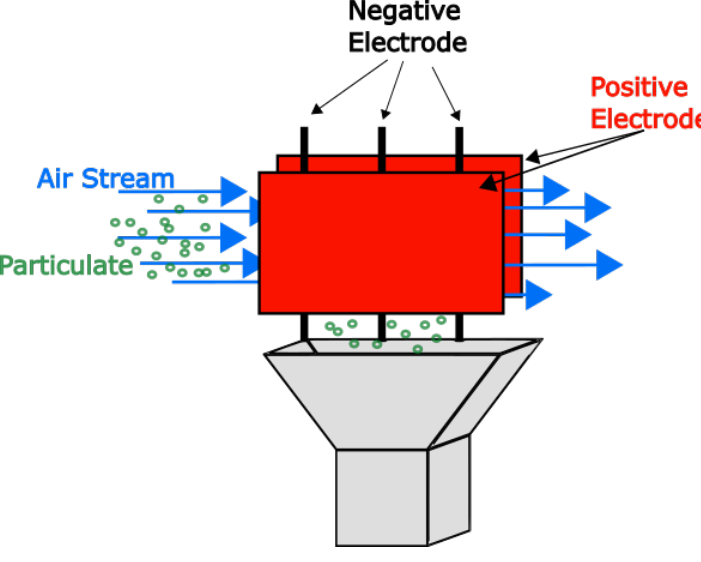
Figure 1. Electrostatic